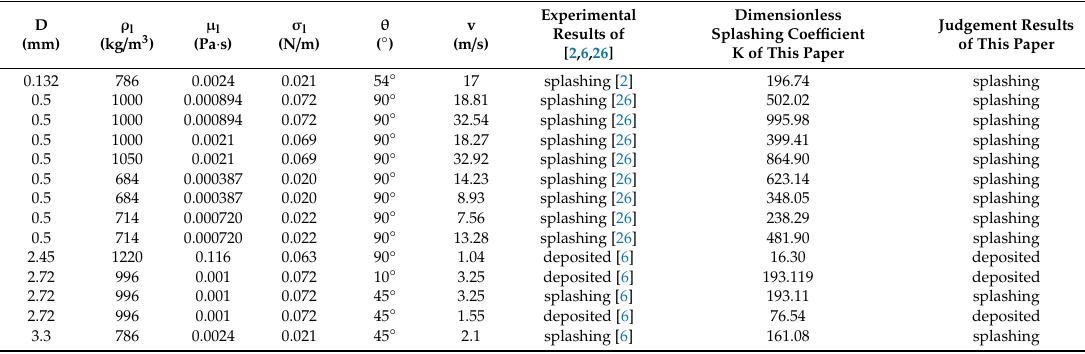
Table 2. Comparison with the experimental results.